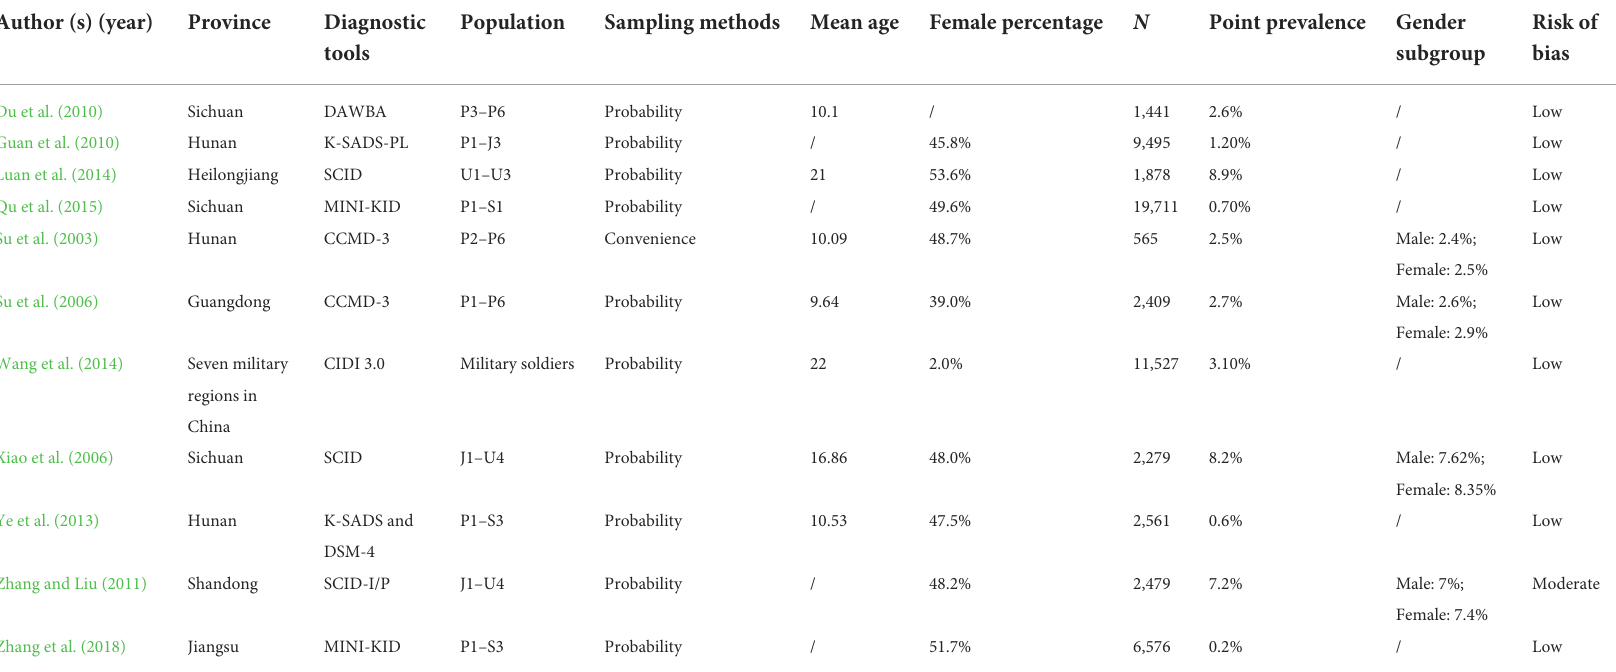
TABLE 1 Social anxiety disorder: study characteristics of the included